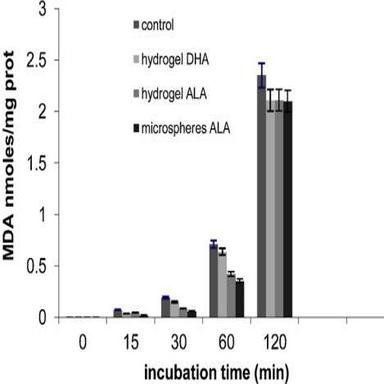
Inhibition of tert-BOOH-induced MDA formation in rat microsomal membranes. The microsomal membranes were incubated with 0.25 × 103 M tert-BOOH at 37 °C under air and in the dark. The results represent the mean ± SD of three separate experiments. Significance was evaluated by the unpaired t-test.